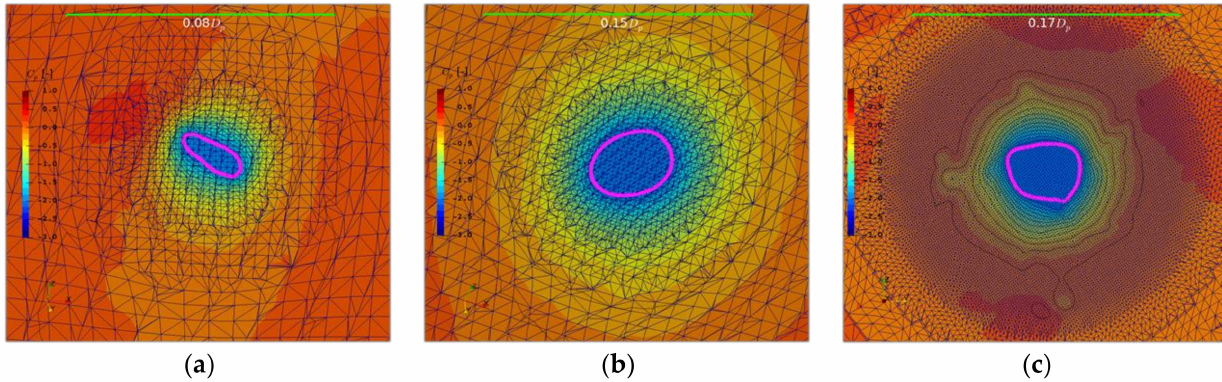
Figure 7. PPTC’11. Mesh comparison: ( a ) helix-normal plane station t 3 ; ( b ) helix-normal plane station t 4 ; ( c ) shaft-normal plane at x = 0.4 · D P